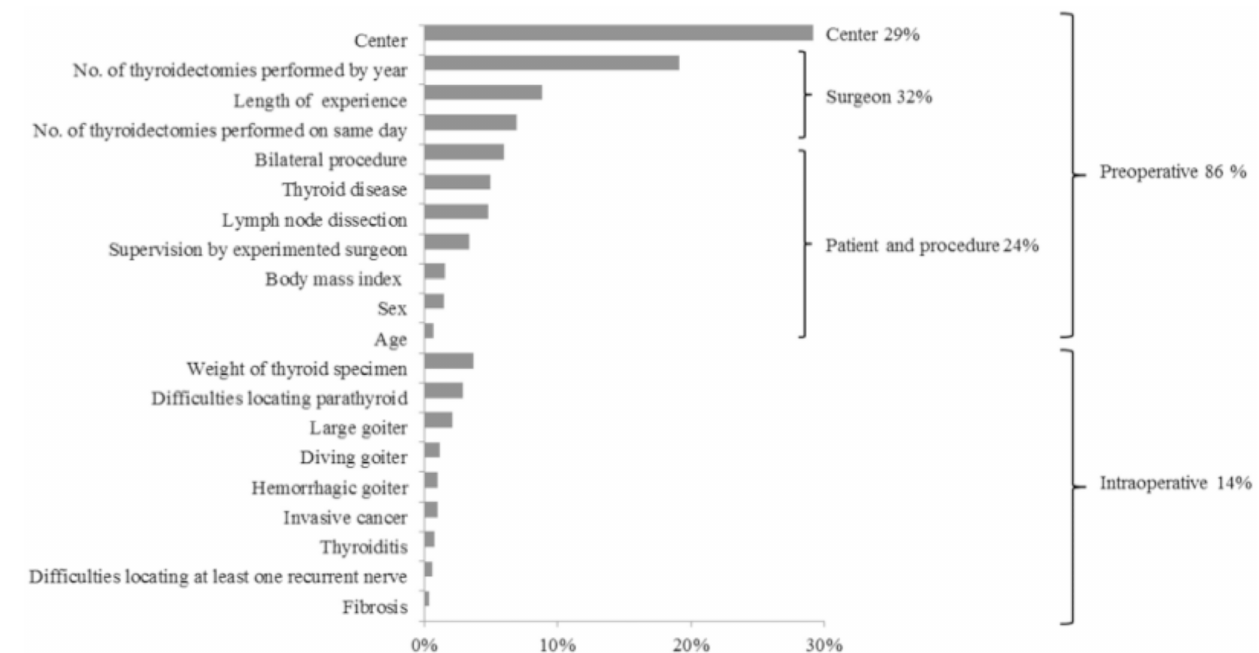
Fig 1. Relative importance of factors associated with operative